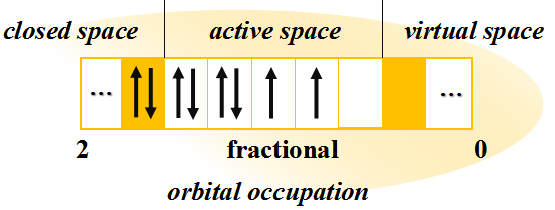
Figure 2. Molecular orbital arrangement and occupation in CASSCF method.